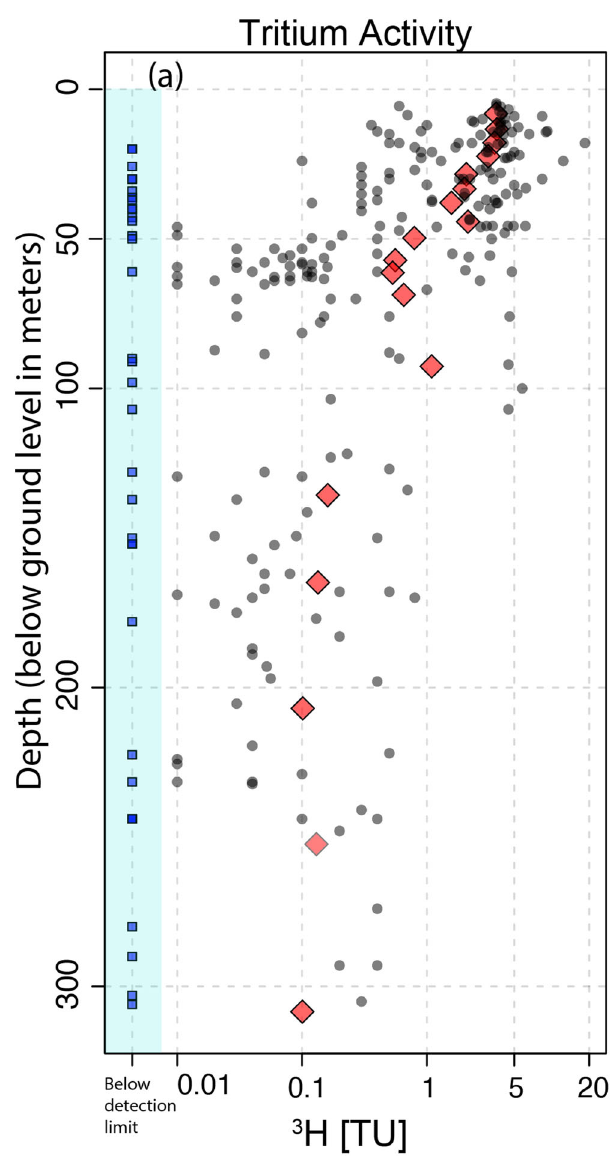
Fig. 1 Tritium activity at different depths from across the Bengal Basin. Tritium activity is shown in black circles. The red diamonds represent an average of over 15 measurements. Blue squares are values below the detection limit, which varies from study to study. See Table S2 for the data